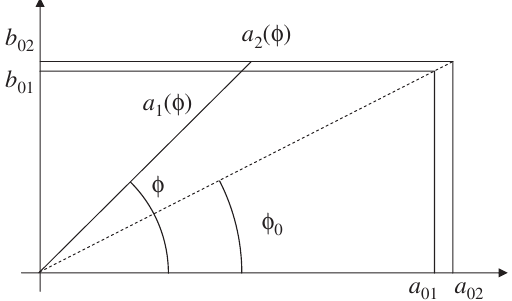
FIG. 6. Cross-sectional view of rectangular beam tube. The horizontal and vertical conducting plates have different wall thicknesses to fit each contact at (cid:4) 0 .